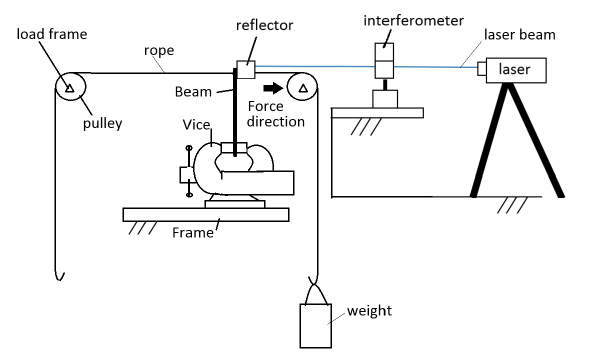
Figure 2: Measurement arrangement scheme.